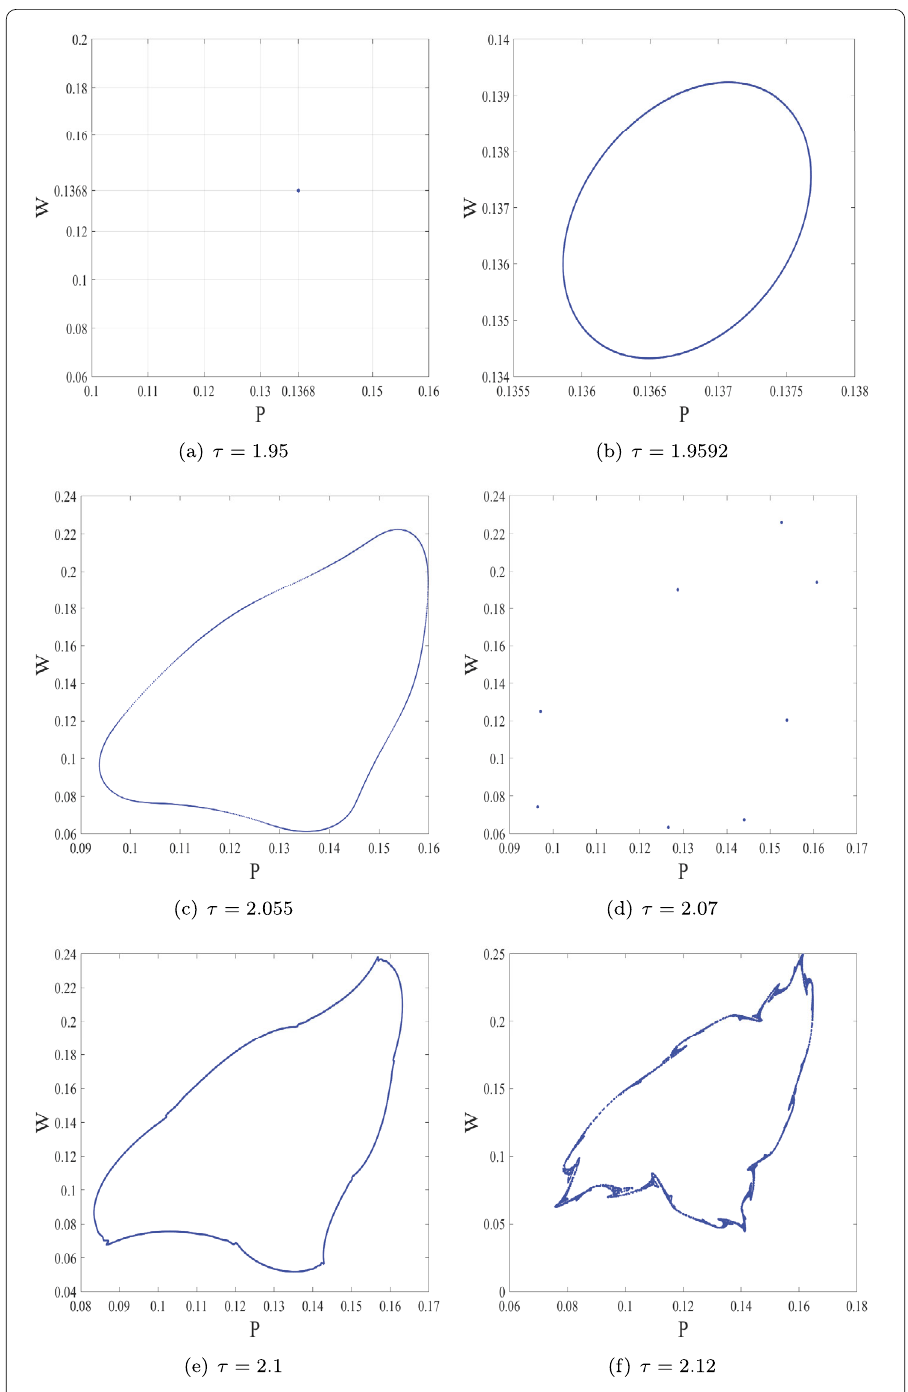
Figure 10 Phase portraits for different values of parameter τ corresponding to Fig. 7 to indicate the dynamic transition of map (10)